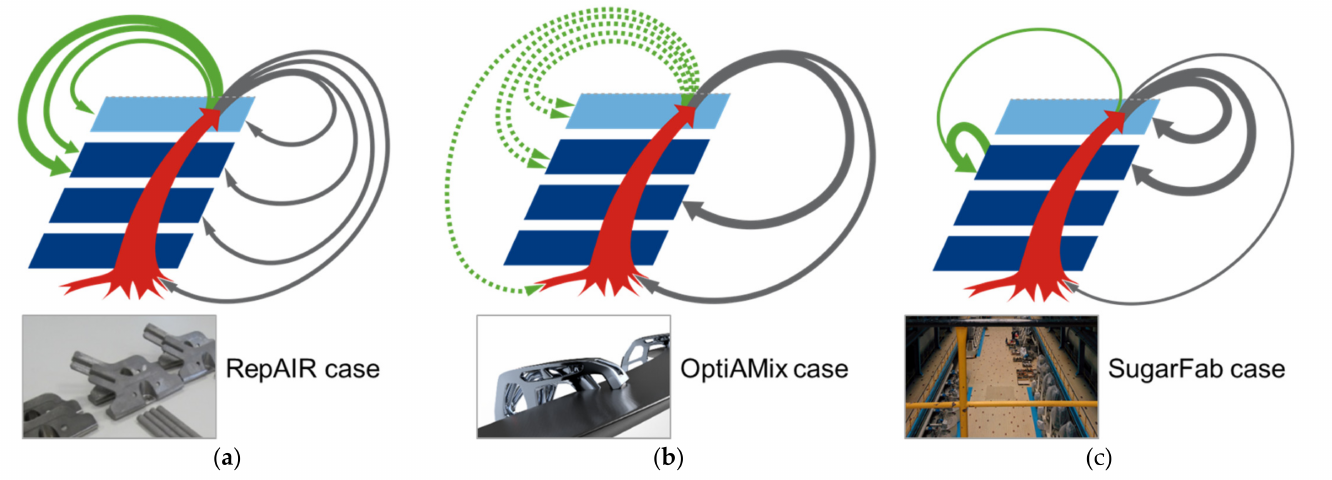
Figure 10. Application cases of the gPLC resulting from collaborative research projects: ( a ) European project RepAIR focusing on Additive Manufacturing of turbine blade brackets in aeronautics; ( b ) German project OptiAMix focusing on multi-criteria decision support in innovation and engineering management; ( c ) digitalization in sugar fabrication (here entitled SugarFab) targeting continuous evolution of production based on data